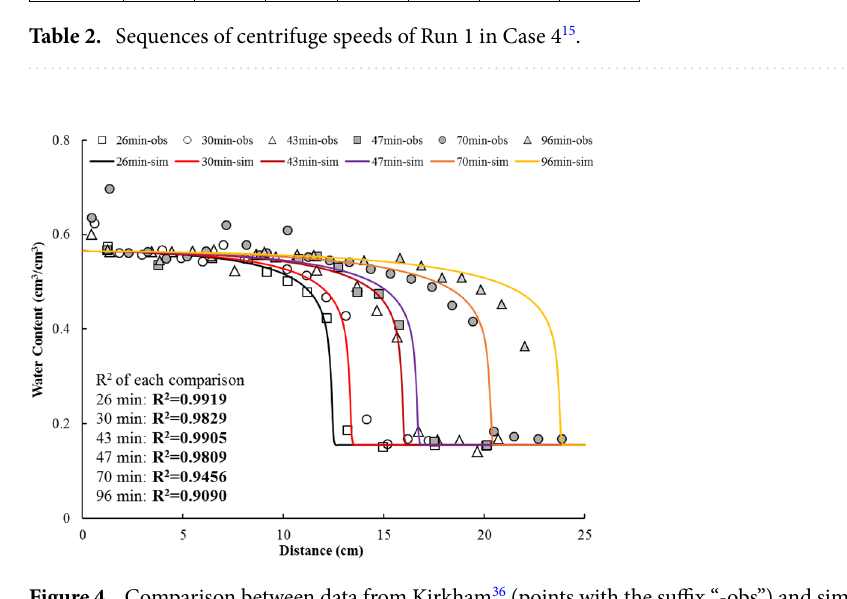
Figure 4. Comparison between data from Kirkham 36 (points with the suffix “-obs”) and simulated